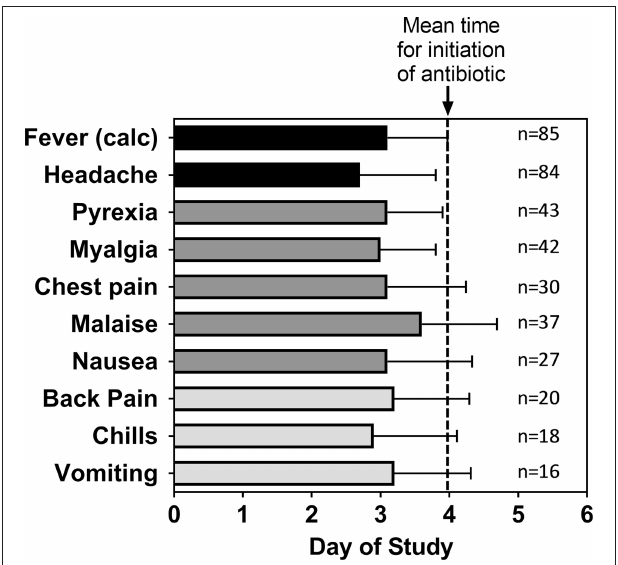
FIGURE 3 | Mean time for adverse events after inhalational exposure to F. tularensis Schu S4. For the indicated number ( n ) of subjects that reported the given Adverse Event, the mean study day ( ± SD) when each of the adverse events were first reported was calculated. The data are compared to the calculated time of fever onset [Fever (calc)] as shown in Table 2 and the mean study day when antibiotic treatment was initiated (dashed line). The data represent only subjects exposed to a target exposure of 25,000